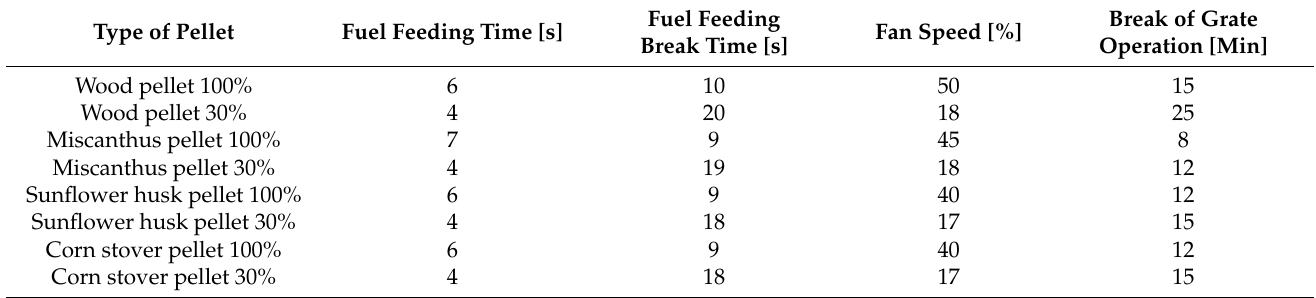
Figure 5. Experimental pellet pictures (wood pellet, ( top left ); sunflower husk pellet, ( top right ); miscanthus pellet, ( bottom left ); and corn stover pellet, ( bottom right )). Table 2. Boiler settings during combustion, full, and minimal